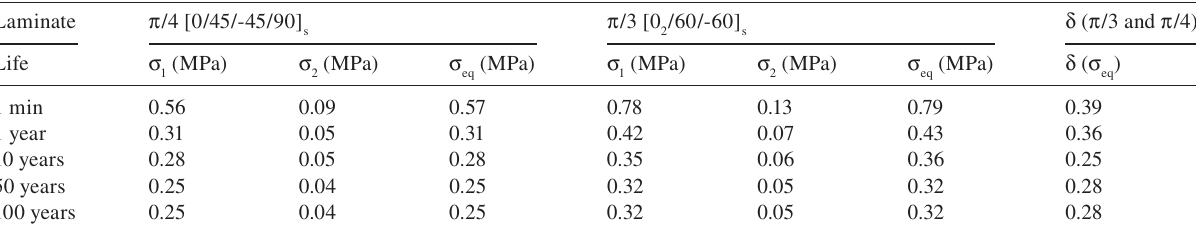
failure stresses for σ eq